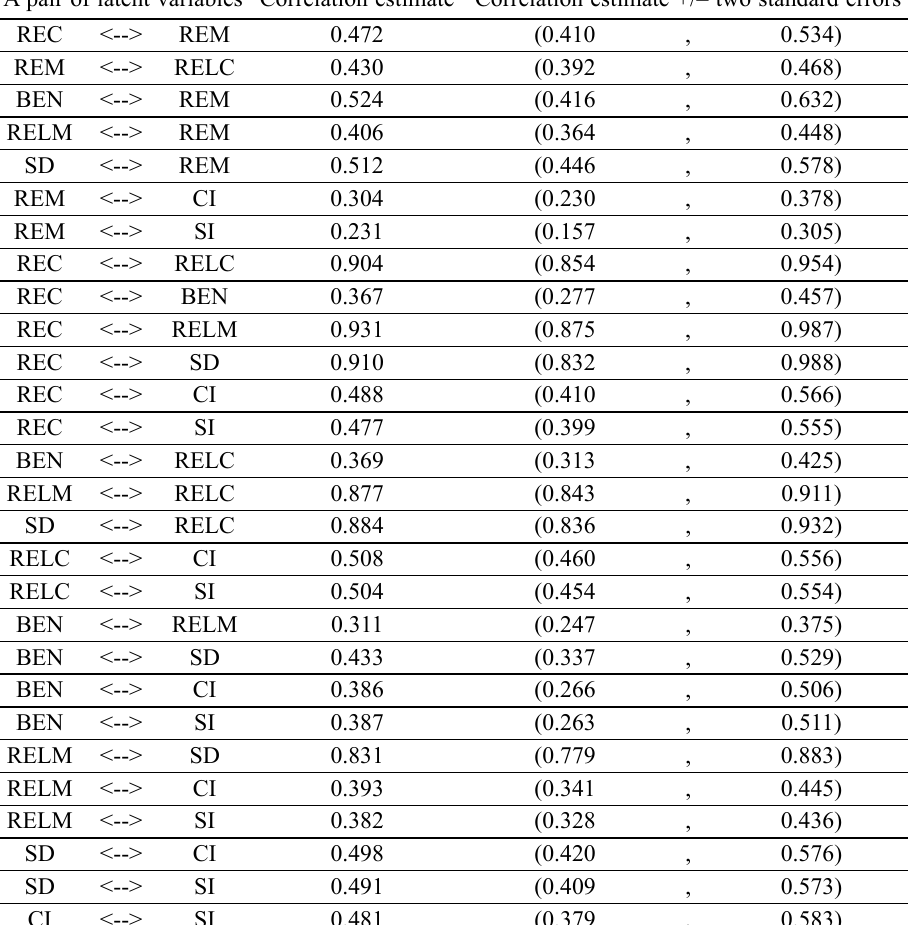
Table 2. A summary of discriminate validity